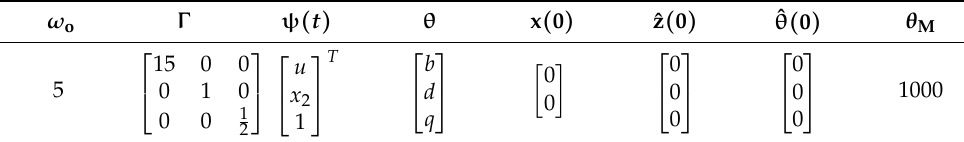
Table 5. Parameters of the simulation of PIESO used for frequency